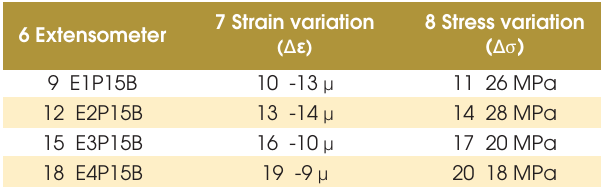
Table 1 – Summary of the strain and stress variations in the extensometers at column P15